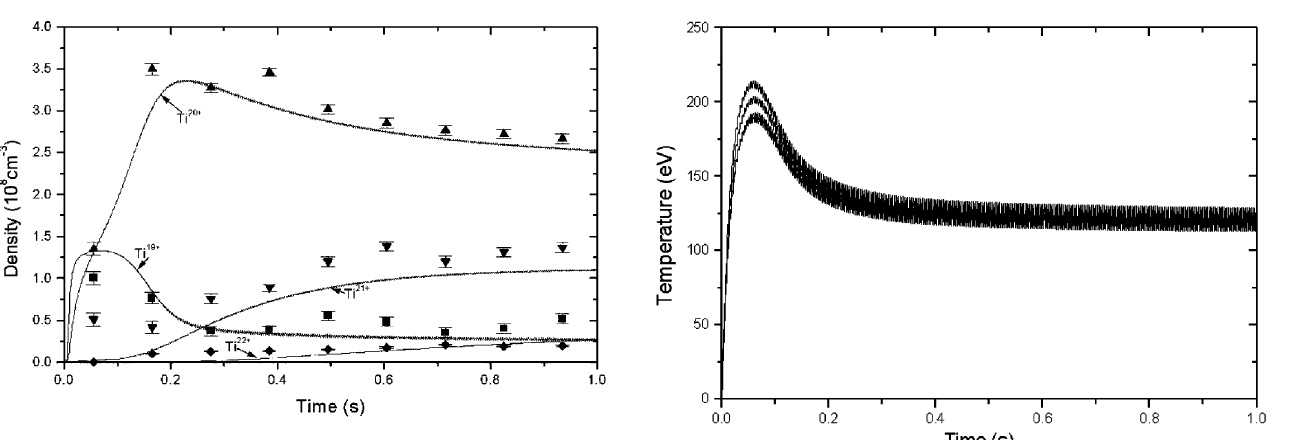
FIG. 8. The number density evolution of lithiumlike to bare titanium ions in the Tokyo EBIT with the effect of DR included. Machine parameters are as described in the main text. Lines show theoretical results, symbols show the associated experi- mental data. Squares, Li-like ions; upward-pointing triangles, He-like ions; downward-pointing triangles, H-like ions; dia- monds, bare